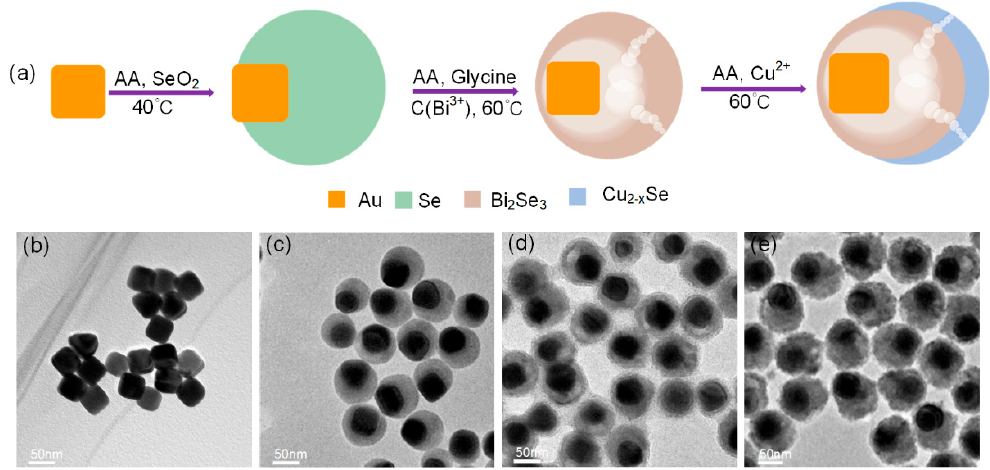
Figure 1. ( a ) Schematic illustration of synthetic process for porous Au/Bi 2 Se 3 /Cu 2-x Se hybrid nano- particles by three-step strategy. TEM images of ( b ) Au nanocubes, ( c ) Au/Se, ( d ) Au/Bi 2 Se 3 , and ( e ) Au/Bi 2 Se 3 /Cu 2-x Se hybrid nanoparticles.